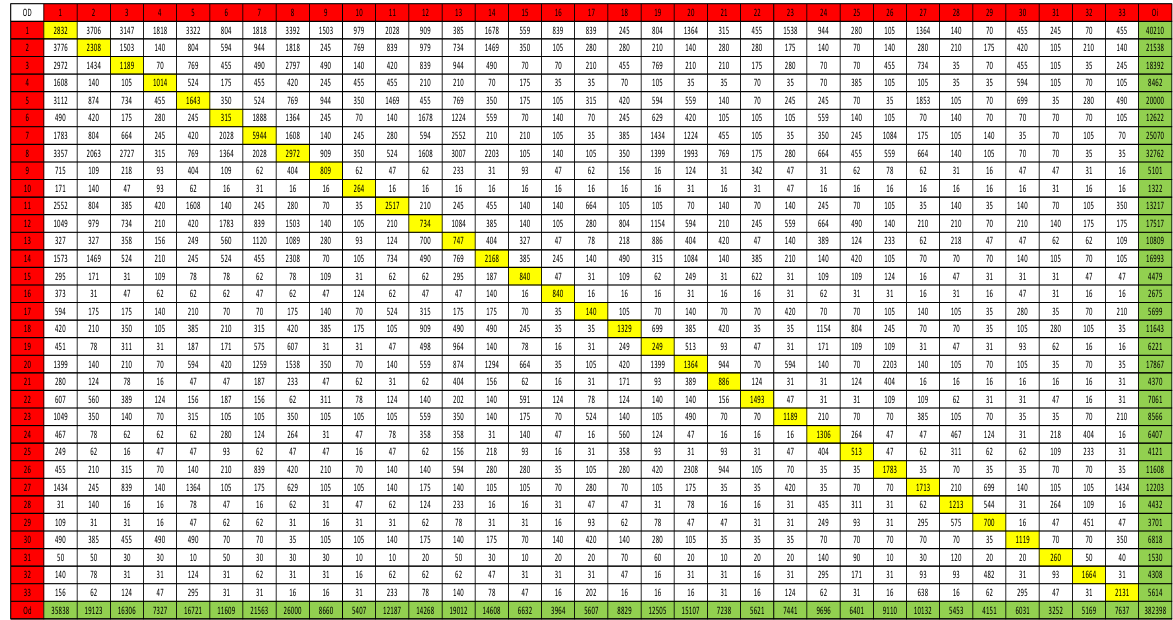
Table 1. Table Matrix Origin - Destination Person/Day (Population)